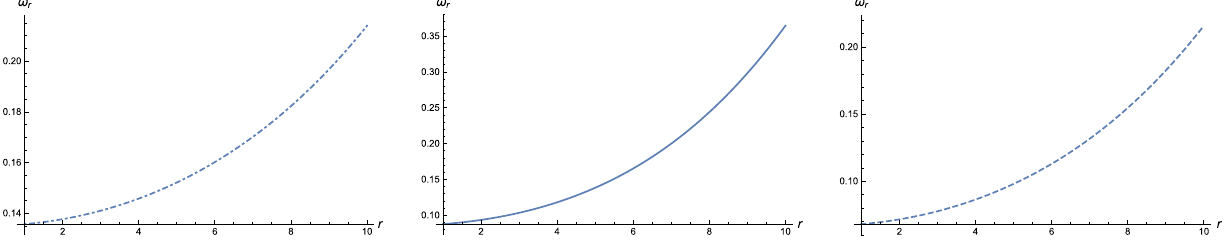
Fig. 13 VariationsoftheradialEoSparameterwithrespecttotheradialcoordinate r (km)ofthestrangestarcandidateHerX-1,SAXJ1808.4-3658, and 4U 1820-30; represented by (left to right) the first, second, and third graphs, respectively